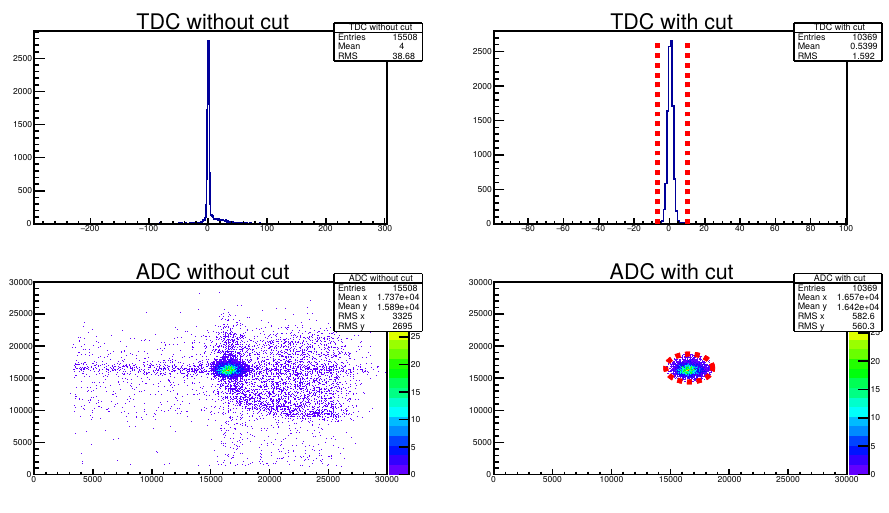
Figure 2. The selection of dp-elastic scattering events using time-of-flight di ff erence and energy losses